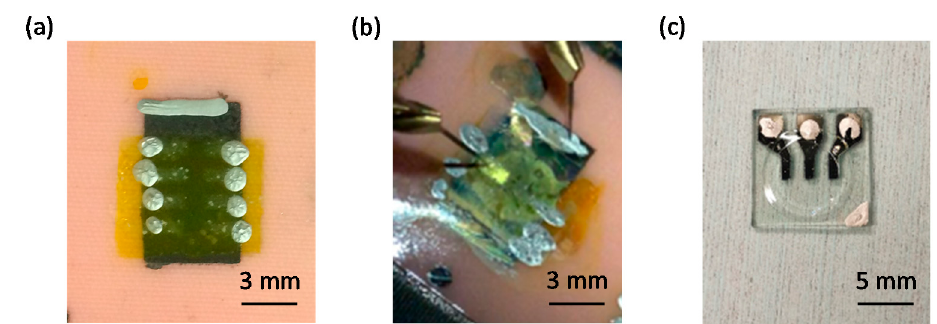
Figure 2. Top view of spray coated SY OLEC devices on textile. ( a ) Light emission off state, ( b ) light emission on state, and top view of spin coated UV OLEC devices on glass slide, ( c ) UV light emission off